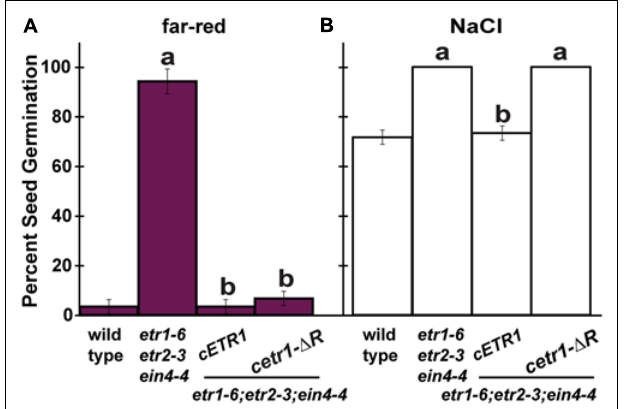
FIGURE 3 |After far-red illumination, the better germination of etr1;etr2;ein4 triple mutants is reversed by both a full-length and truncated ETR1 transgene lacking the receiver domain. (A) The percent of germination 7 days after treatment with far-red light for wild-type, etr1-6;etr2-3;ein4-4 triple mutants and these triple mutants transformed with cDNA for full-length ETR1 ( cETR1 ) or a truncated ETR1 lacking the receiver domain ( cetr1- Δ R ) was determined. (B) For comparison, the percent germination of these seed lines 7 days after sowing on 150 mM NaCl in the presence of continuous white light was determined. Data were analyzed by t -tests and differences considered statistically significant with P < 0.05. a Significant difference from wild-type germinated under the same conditions. b Significant rescue of germination by the transgene.